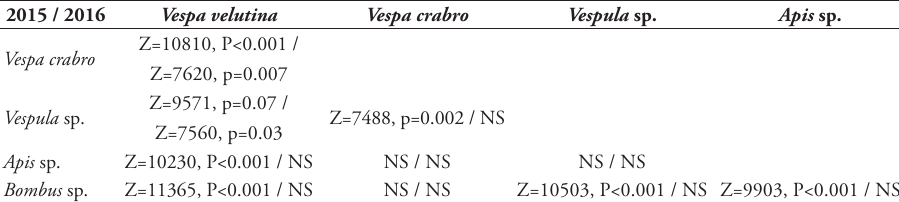
Vespula sp. Apis